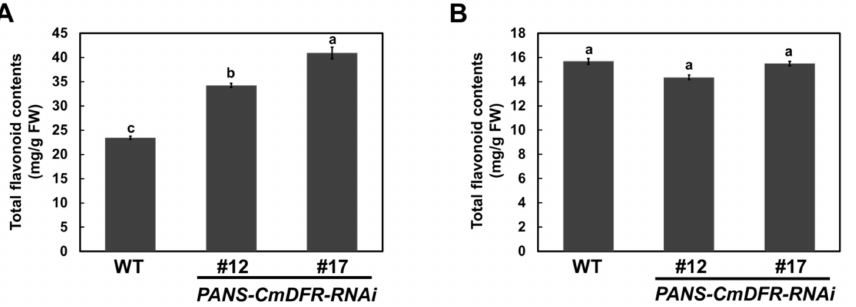
Figure 6. Total flavonoid contents in WT and PANS-CmDFR-RNAi transgenic chrysanthemum ray florets ( A ) and leaves ( B ). All results represent mean values ± SD from three independent biological replicates. Different letters above the bars indicate significantly different values ( p < 0.01) calculated using one-way ANOVA followed by Duncan’s multiple range